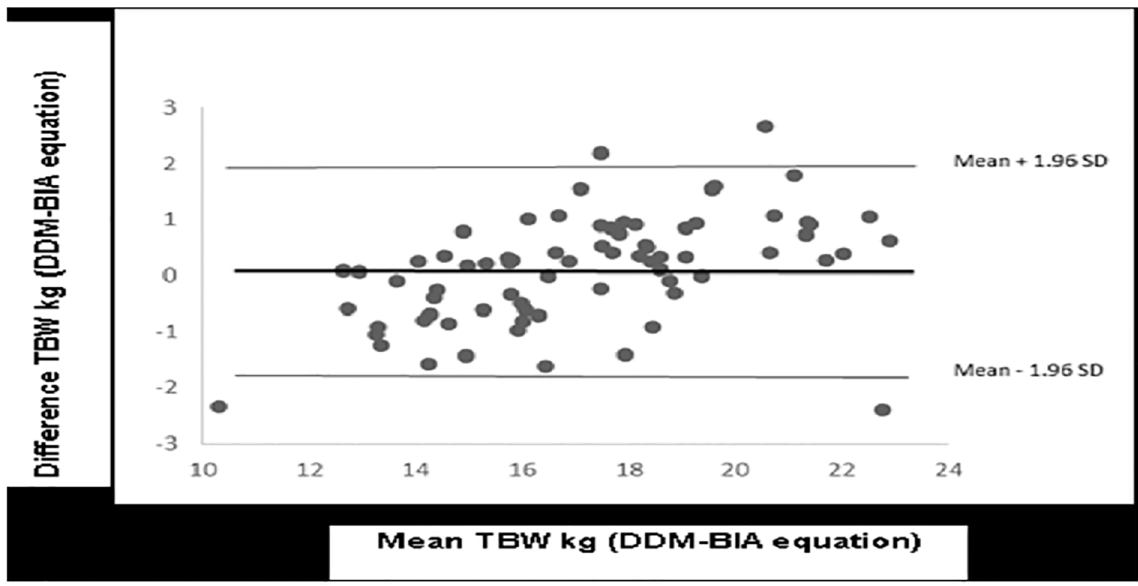
Fig 3. Bland and Altman plot of the difference in TBW (kg) measured by DDM and predicted by the BIA equation against their mean. The horizontal line represents the bias and the upper and lower horizontal lines indicate the 95% CI limits of agreement (±1.96 x SD) for bias.